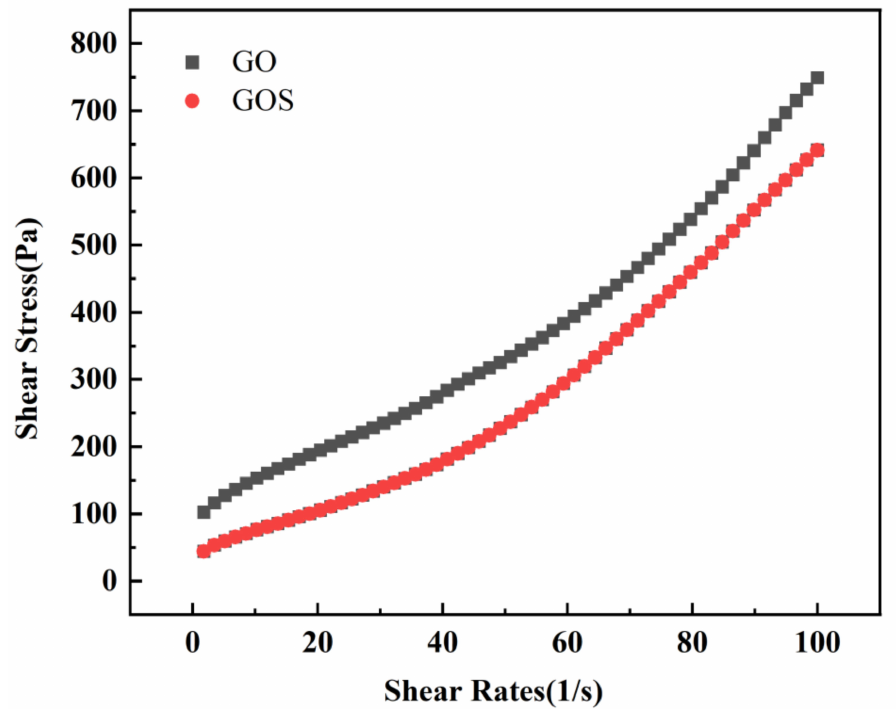
Figure 15. Shear rate-shear stress H-B fitting curves of GO and GOS (0.01%) cement-based